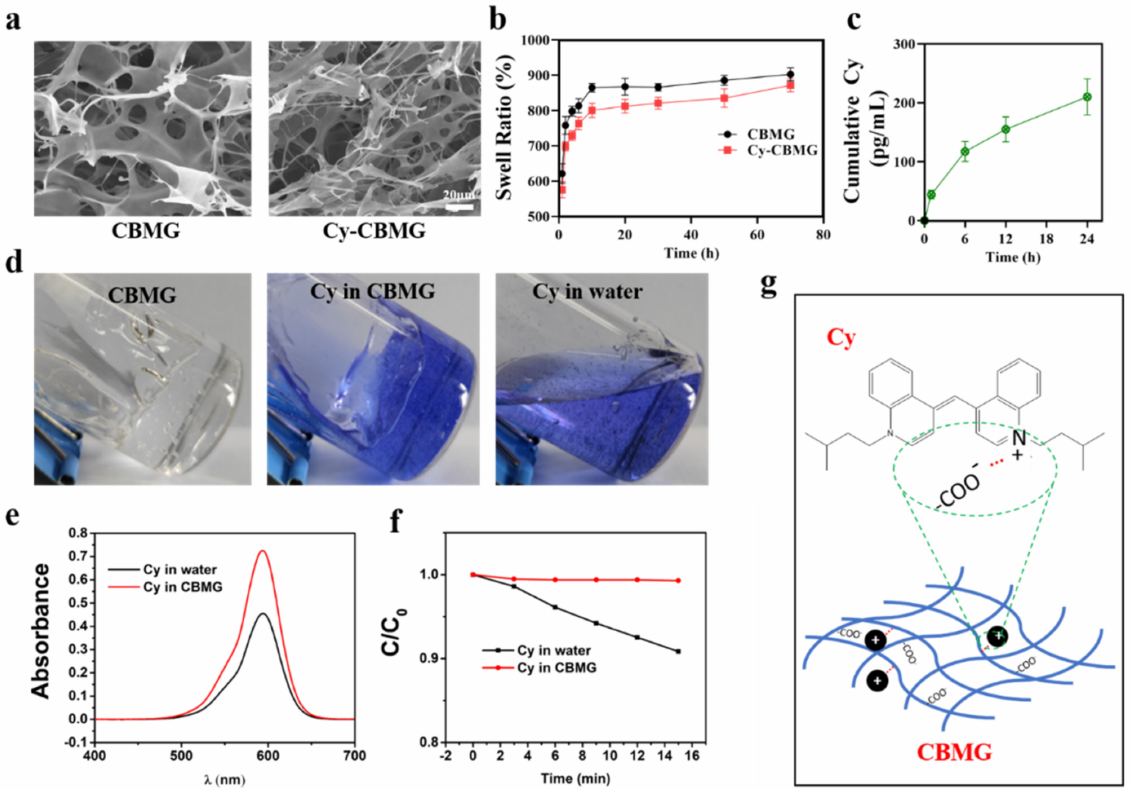
Figure 1. The characteristic of Cy-CBMG and the effects of CBMG on the solubility and photostability of Cy. ( a ) The representative SEM images of CBMG and Cy-CBMG. ( b ) The swell ratio of CBMG and Cy − CBMG at setting time points. ( c ) The releasing behavior of Cy from Cy − CBMG in vitro. ( d ) Images of Cy in water and CBMG. ( e ) The absorption of Cy in CBMG and water dissolved in EtOH. ( f ) Normalized absorbance of Cy irradiated by 600 nm laser in different media. ( g ) Schematic electrostatic interactions between carboxyl group of CBMG and tertiary amino group of